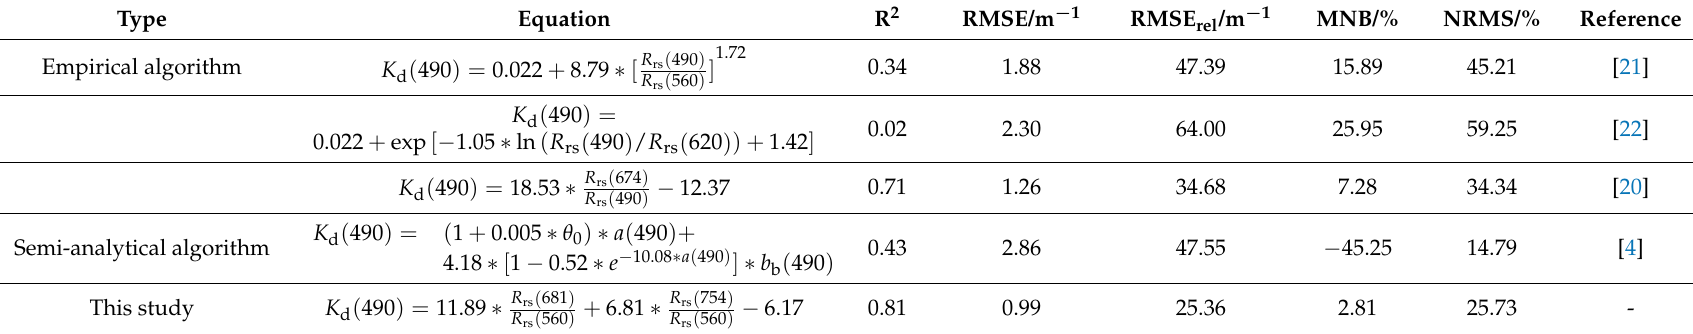
Table 2. Comparison of the performance of the existing and proposed K d (490) estimation algorithms using the OLCI-derived R rs .